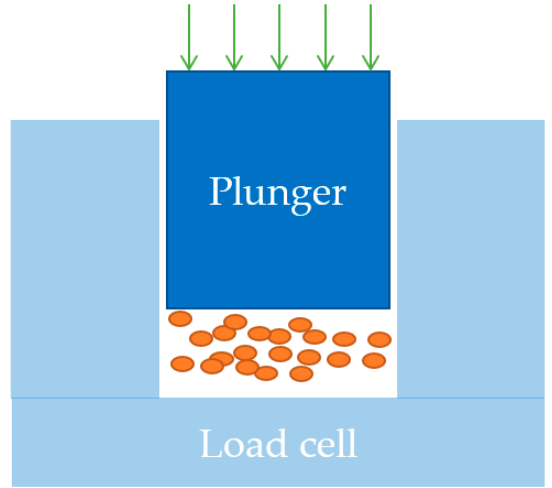
Figure 2. A schematic of the hydraulic press and load